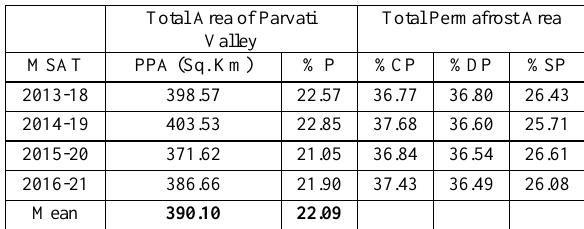
Table 5: The table summarizing the total probable permafrost area (in Sq. Km and %) and the percentage of permafrost area in different categories (CP, DP, SP) using MSAT for each consecutive years starting from 2013 to